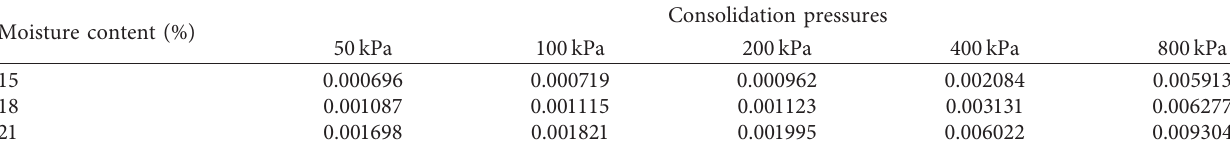
Table 7: Secondary consolidation coefficient table of expansive soil under different moisture content